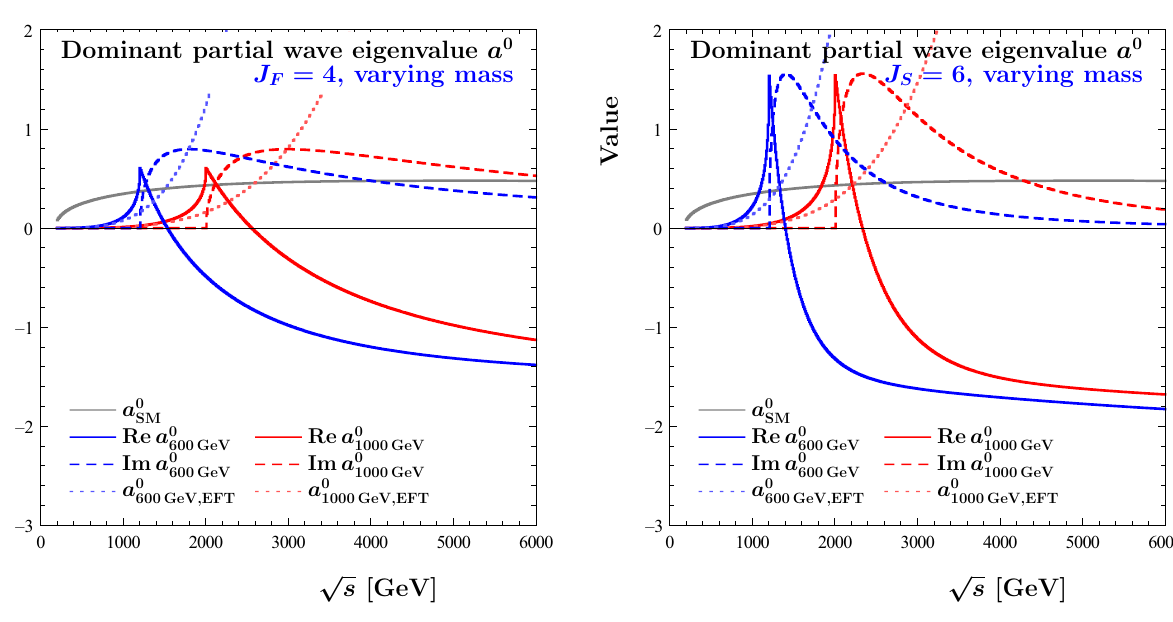
Fig. 4 Dominating iso-singlet, j = 0 partial wave amplitudes, a 0 as a function of the diboson center of mass energy, shown for the pure contribution of a single J F = 4 fermion multiplet (left panel) and of a single J S = 6 scalar multiplet (right panel), for